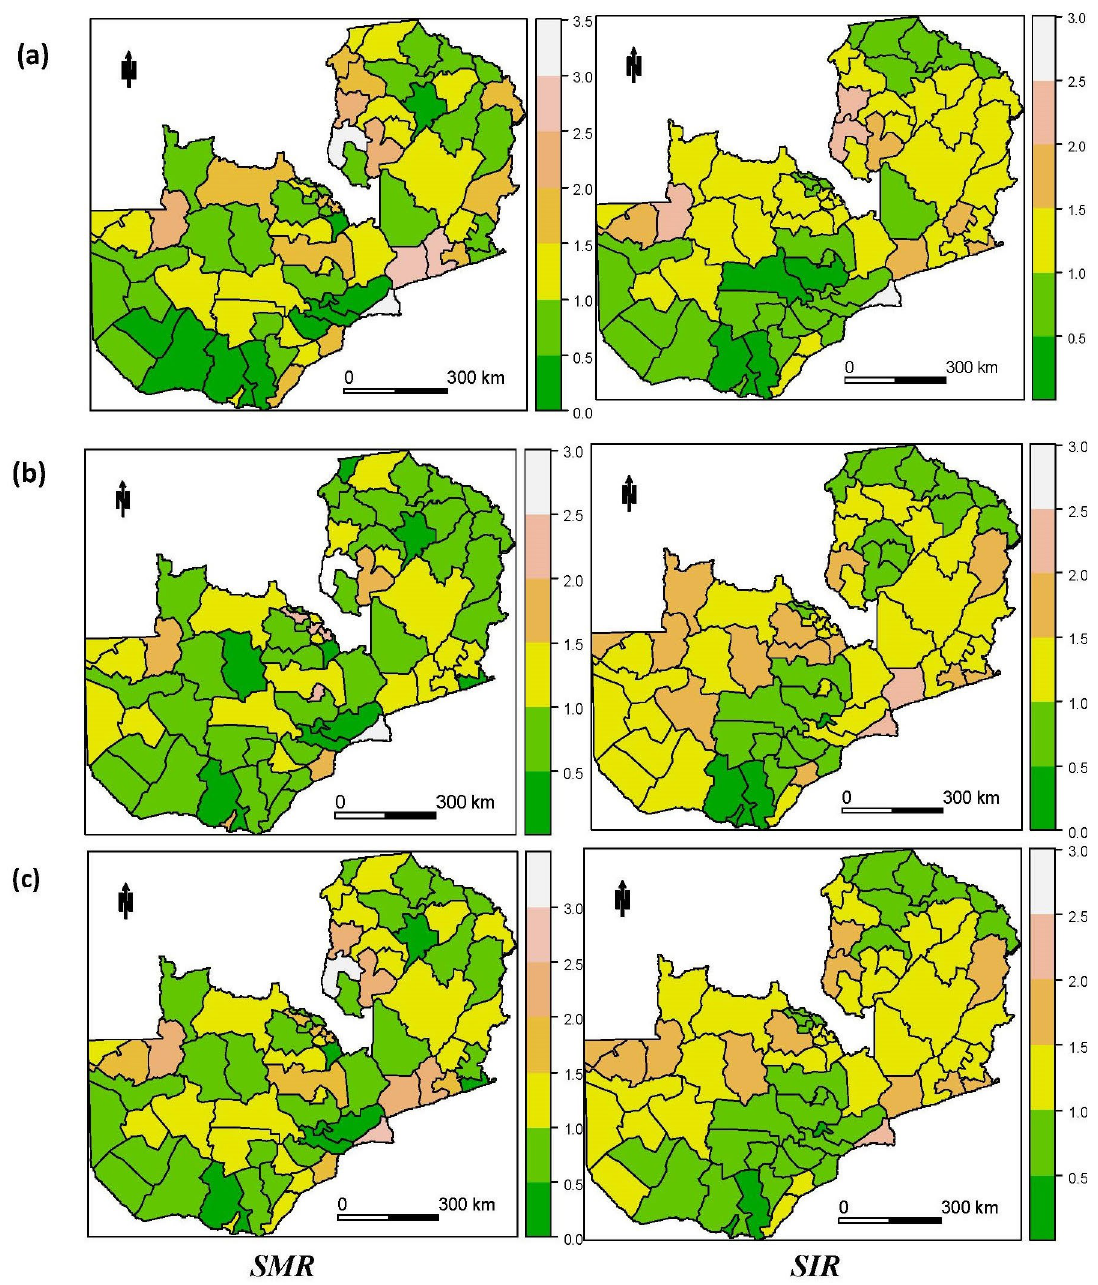
Fig 4. Relative risk of malaria mortality (SMR) and incidence (SIR) among under-fives, five and over and all ages, 2000–2015. (A) = Under-fives, (B) = five and over (C) = all ages.